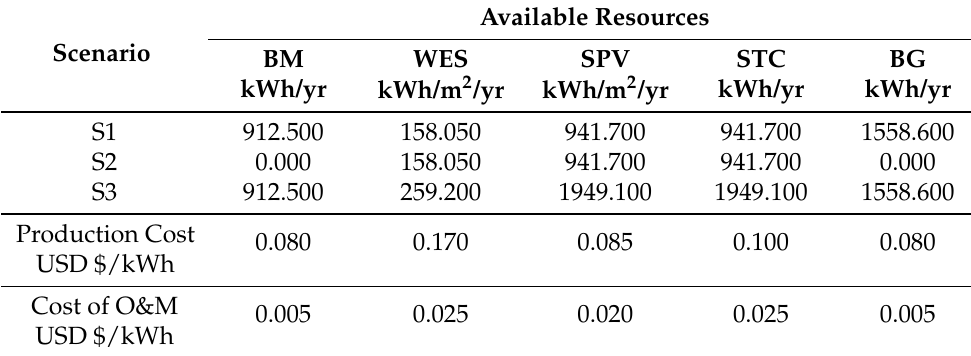
Table 2. Values of renewable energy resources and the cost of energy obtained from the proposed optimization